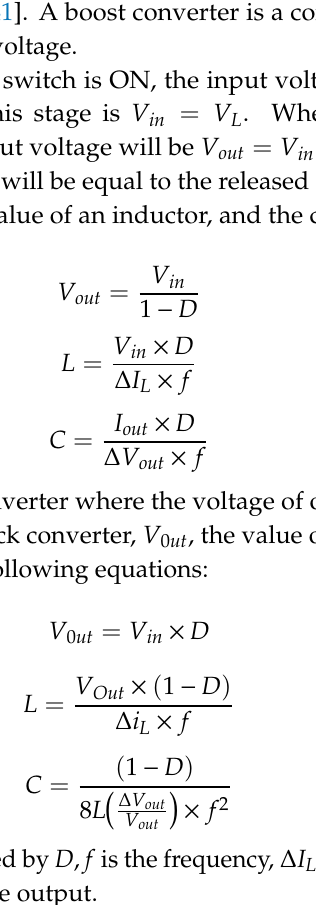
Figure 4. The complete prototype of the proposed charge controller.